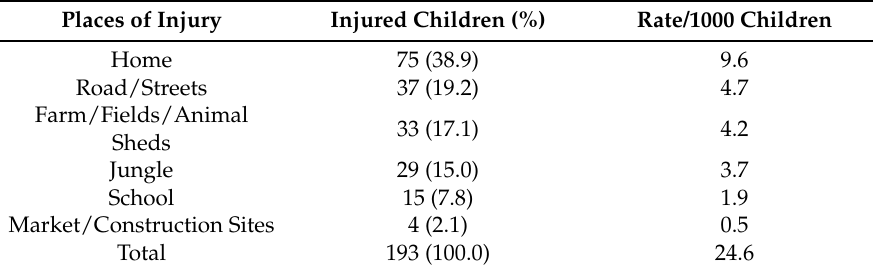
Table 4. Distribution of injured children by places of